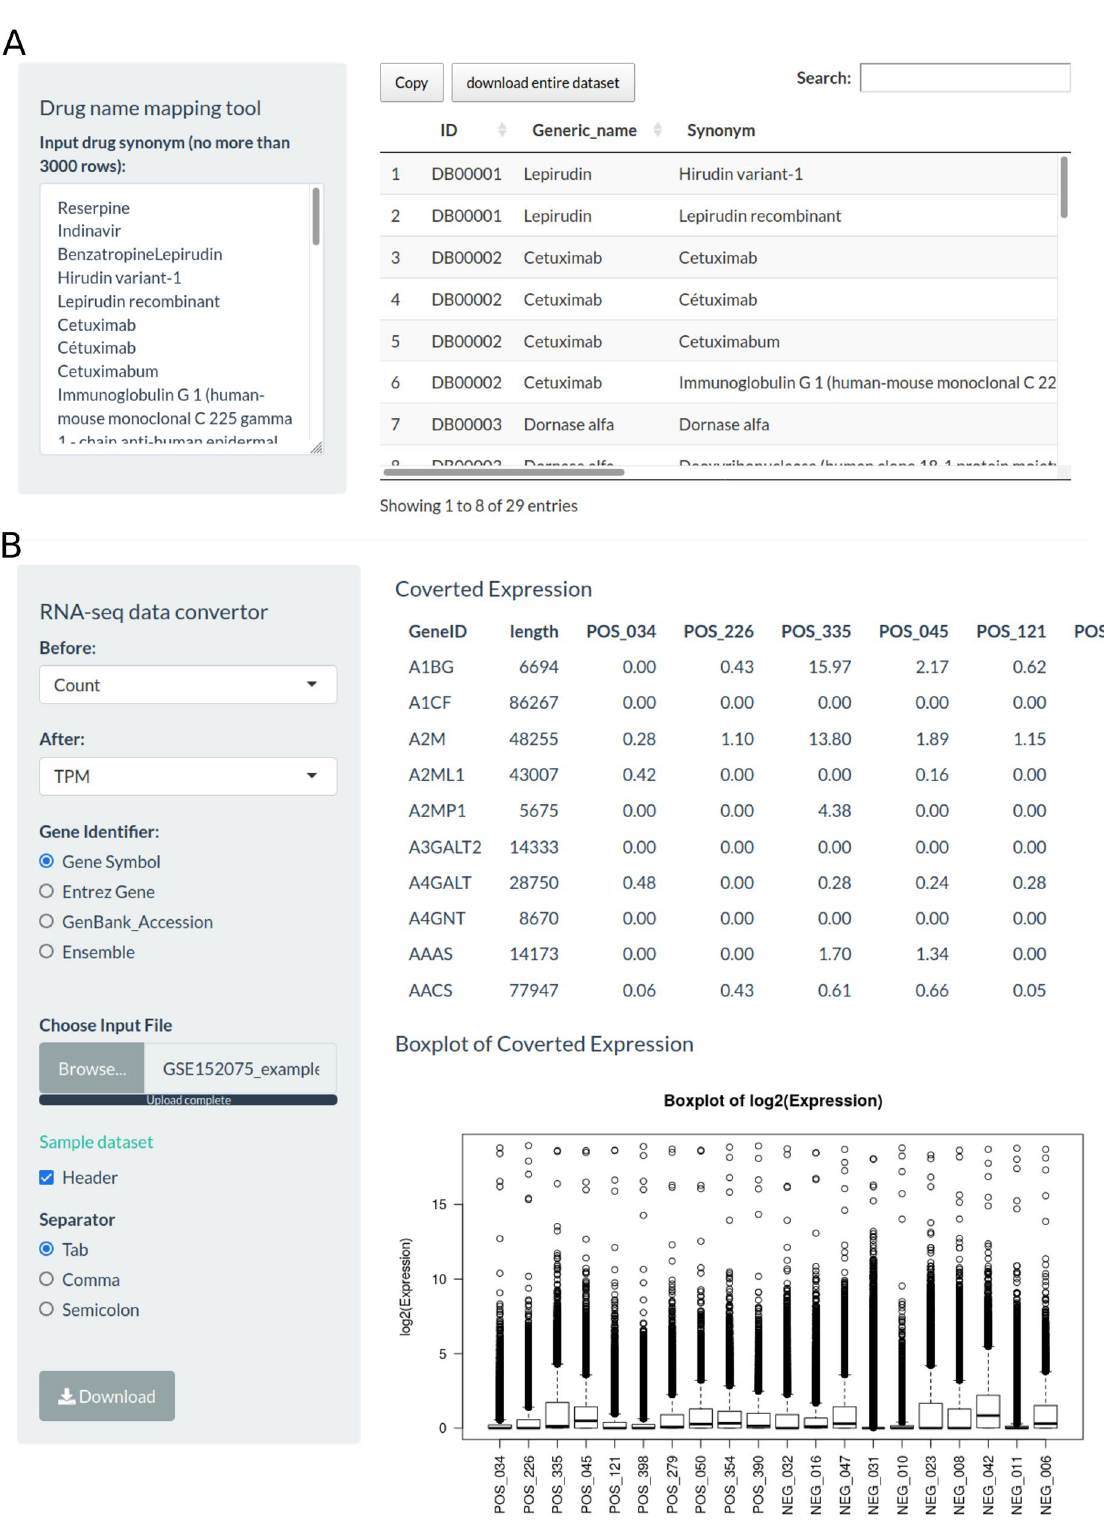
Figure 4. Screenshot of drug name mapping and RNA-seq measure conversion functions. ( A ) A total of 35,694 drug aliases of 13,339 drugs from the Drugbank database were included. You can enter or paste any drug names to find out their generic names. The obtained generic name can be used for drug-target protein network analysis. ( B ) Read counts data of RNA-seq data can be converted into TPM or FPKM data, and FPKM data can be converted into TPM data. Corresponding TPM data can be used to analyze immune